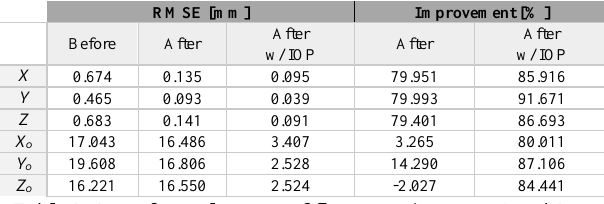
Table 9: Out-of-sample errors of fluoroscopic system 1 and